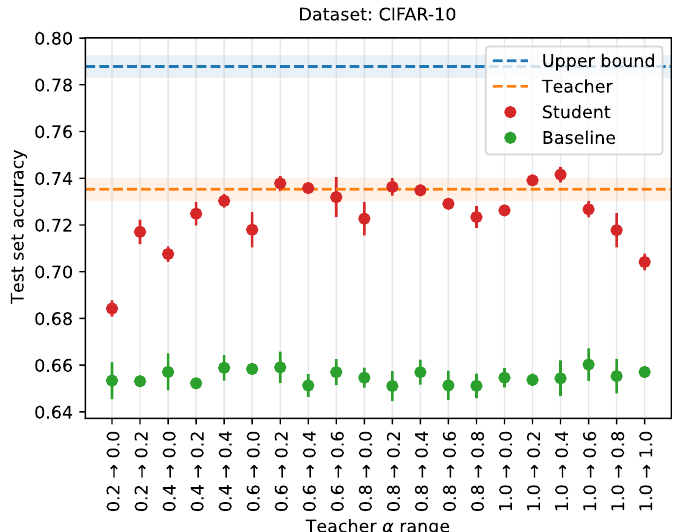
Figure 6. Training a student network with knowledge distillation, with linearly annealing values for hyperparameter α . The range for α is given on the x-axis, while the y-axis gives the test set performance. Averages over three runs. Shaded areas and error bars indicate the standard